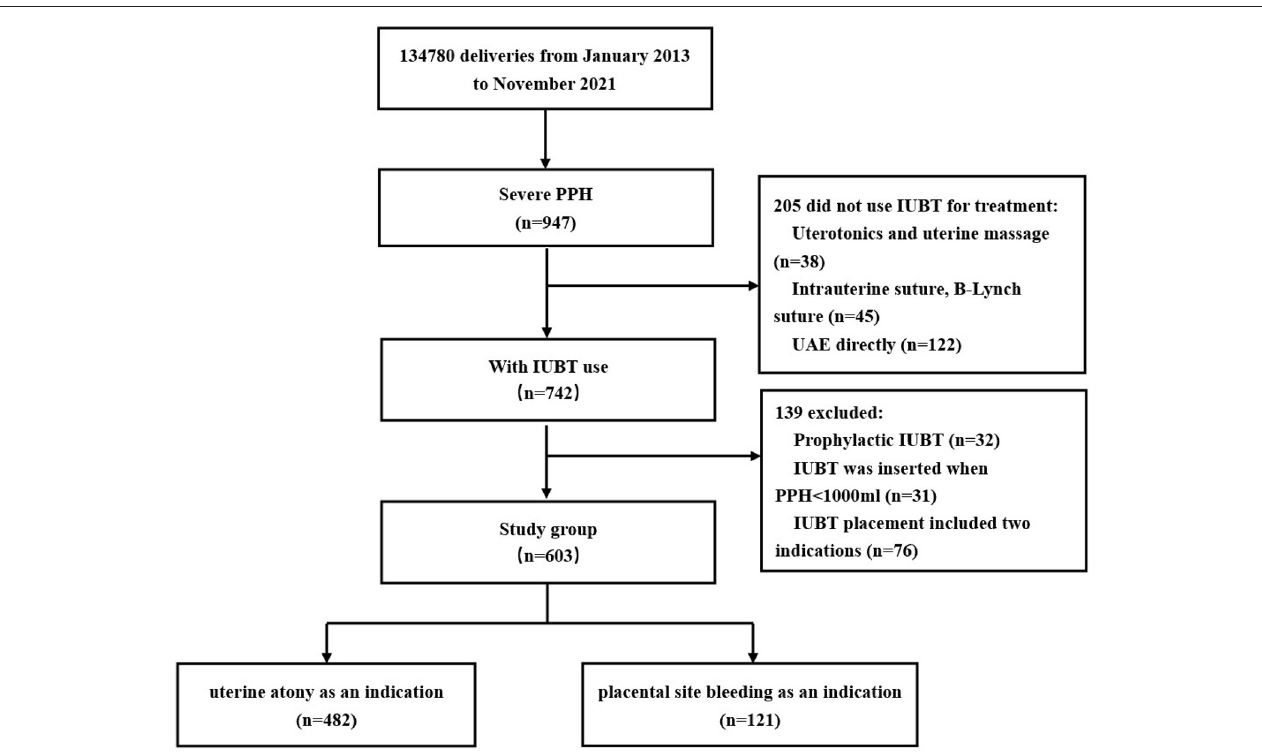
FIGURE 1 | Flowchart. IUBT, intrauterine balloon tamponade; PPH, postpartum hemorrhage; UAE, uterine artery